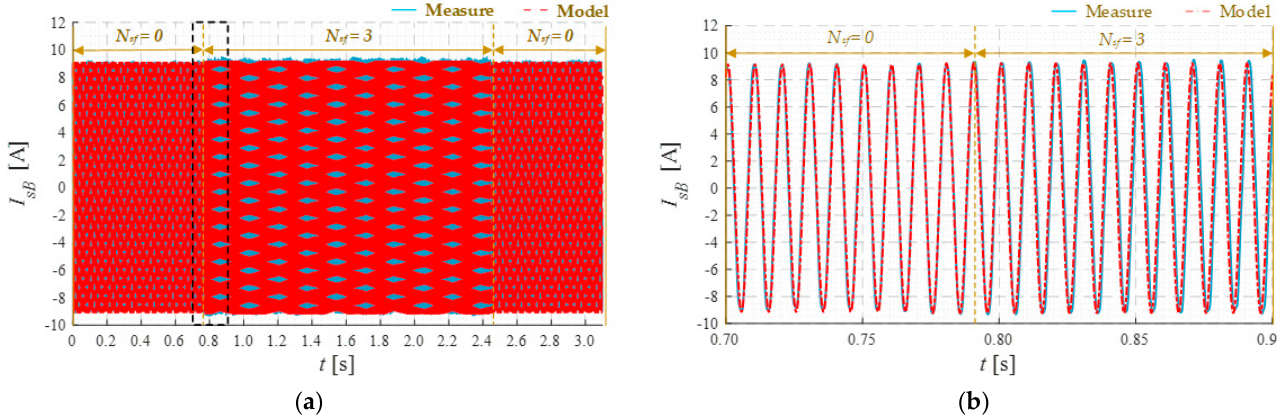
Figure 2. Experimental verification of the proposed mathematical model of PMSM with short circuits in the stator winding: ( a ) instantaneous occurring of the shorted turns; ( b ) instantaneous occurring of the shorted turns—zoom; T L = T N , f s = 100 Hz.